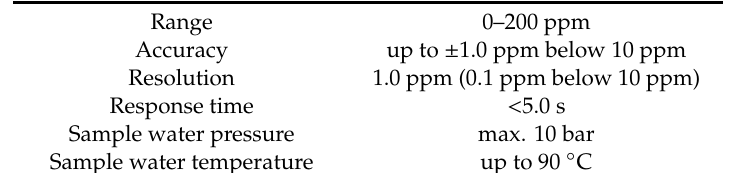
Table 2. Specifications of the oil-in-water online sensor (OMD-32).